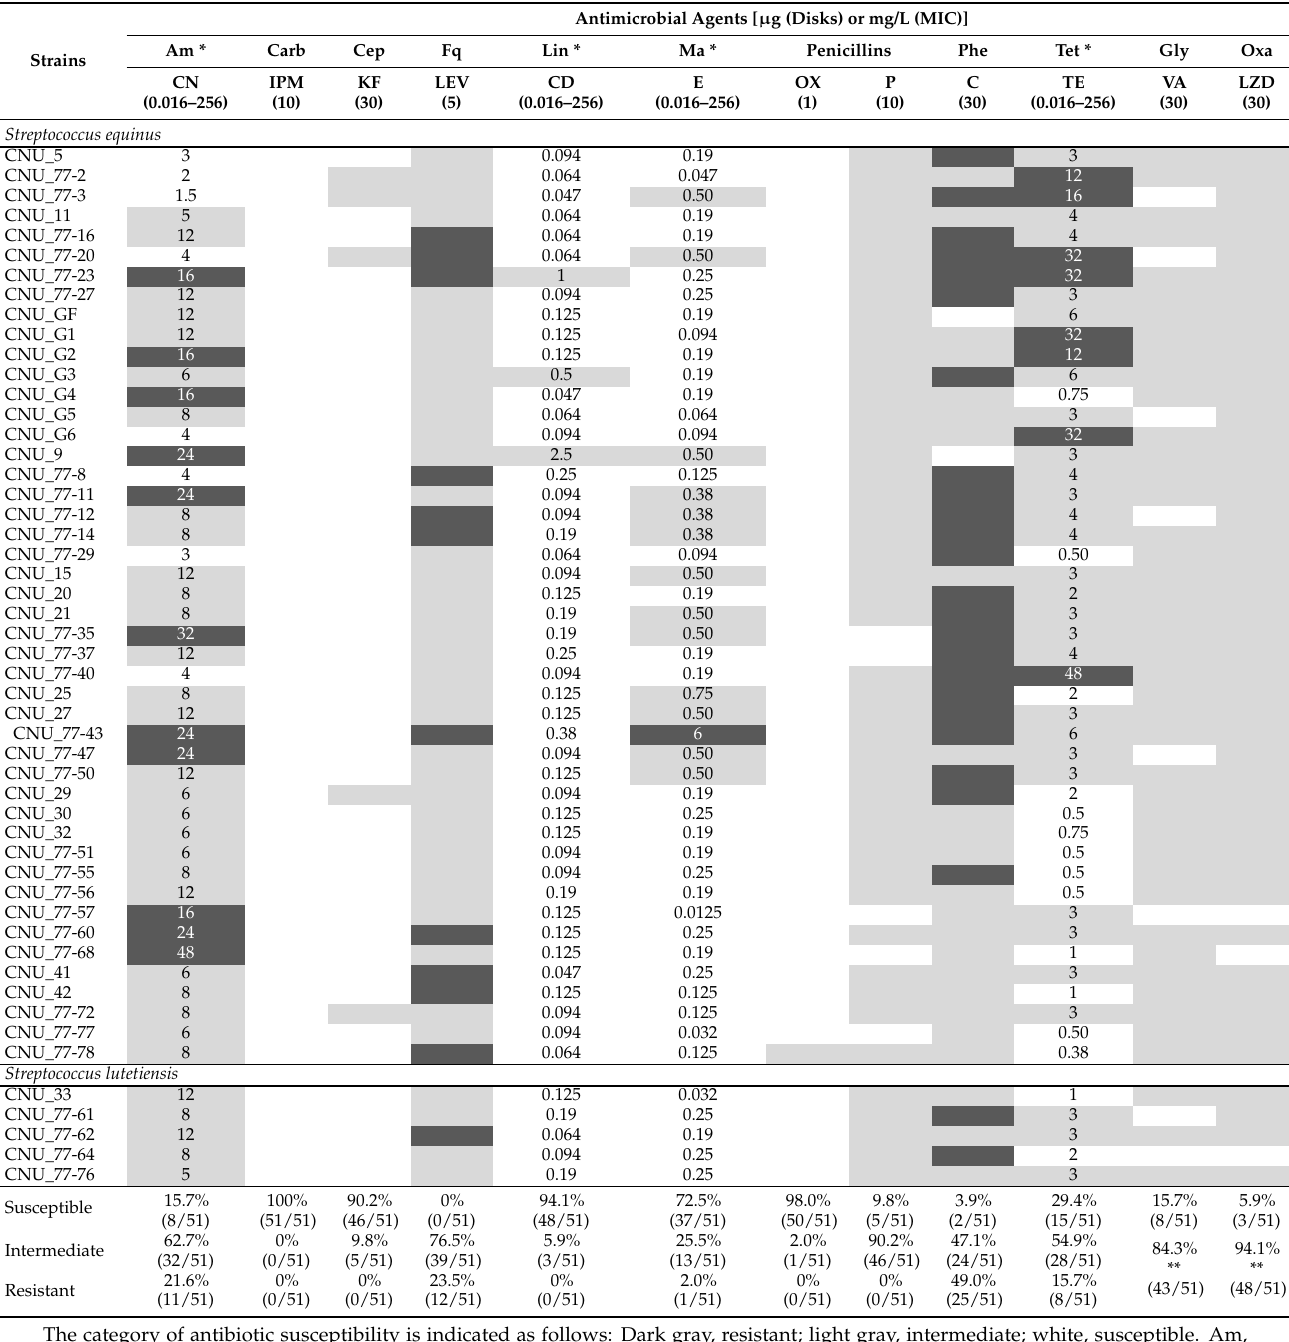
Table 3. Antimicrobial-resistance profile of 51 SBSEC isolates in this